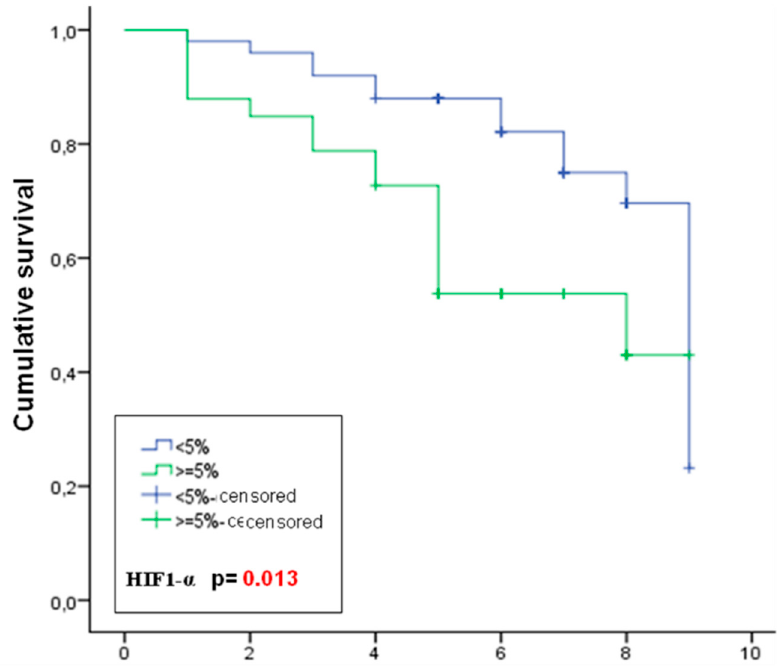
Figure 2. Kaplan–Meier curves of disease-free survival of patients stratified by HIF-1 α expression.